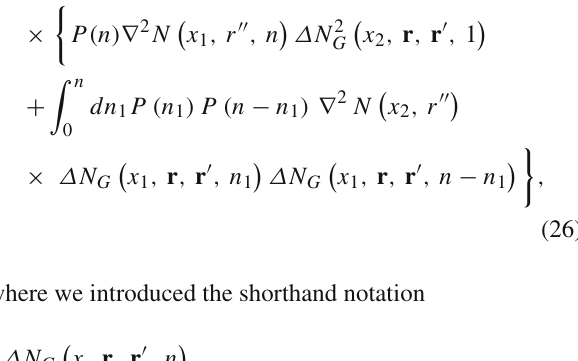
to integrate over the rapidity of J /ψ in the bin and sum over all pos- sible distributions between the upper and lower pomerons, such that n 1 + n 2 + n 3 =